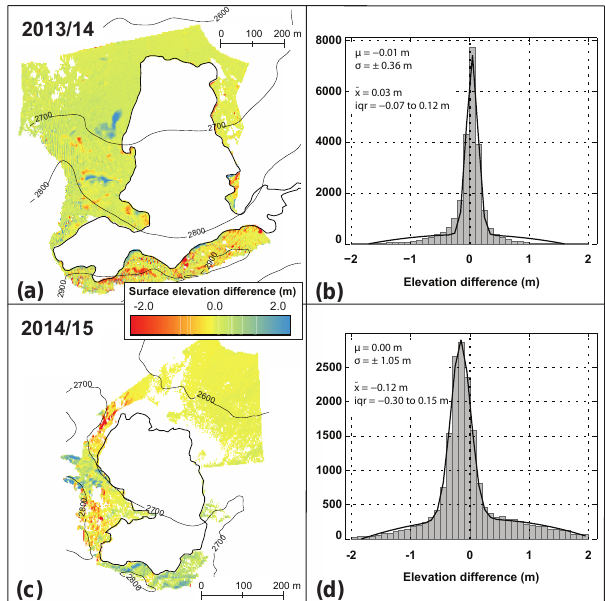
Figure 3. Comparison of annual surface elevation changes over sta- ble terrain obtained by differencing of TLS-derived DEMs from two consecutive years. Spatial and corresponding frequency distri- butions of these changes for (a, b) St. Annafirn (2013/14) and (c, d) Pizolgletscher (2014/15). The black curves in (b) and (d) are normal fits over the data. In addition, the mean ( µ ) and median ( e x ) elevation differences, as well as corresponding standard deviations ( σ ) and interquartile ranges (iqr) are